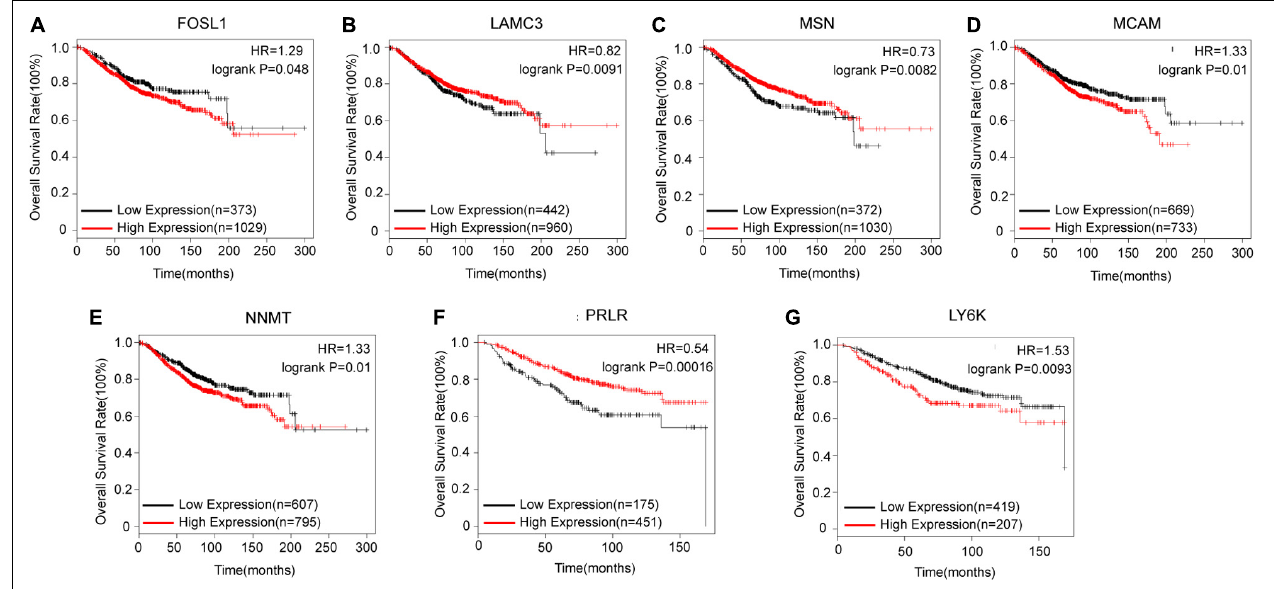
FIGURE 4 | Kaplan–Meier survival curves for mRNAs correlated with lnc-TRDMT1-5 (n = 1402). (A) Survival curves for FOSL1. (B) Survival curves for LAMC3. (C) Survival curves for MSN. (D) Survival curves for MCAM. (E) Survival curves for NNMT. (F) Survival curves for PRLR. (G) Survival curves for LY6K. Horizontal axis, survival time (days); vertical axis, survival rate. HR: Hazard